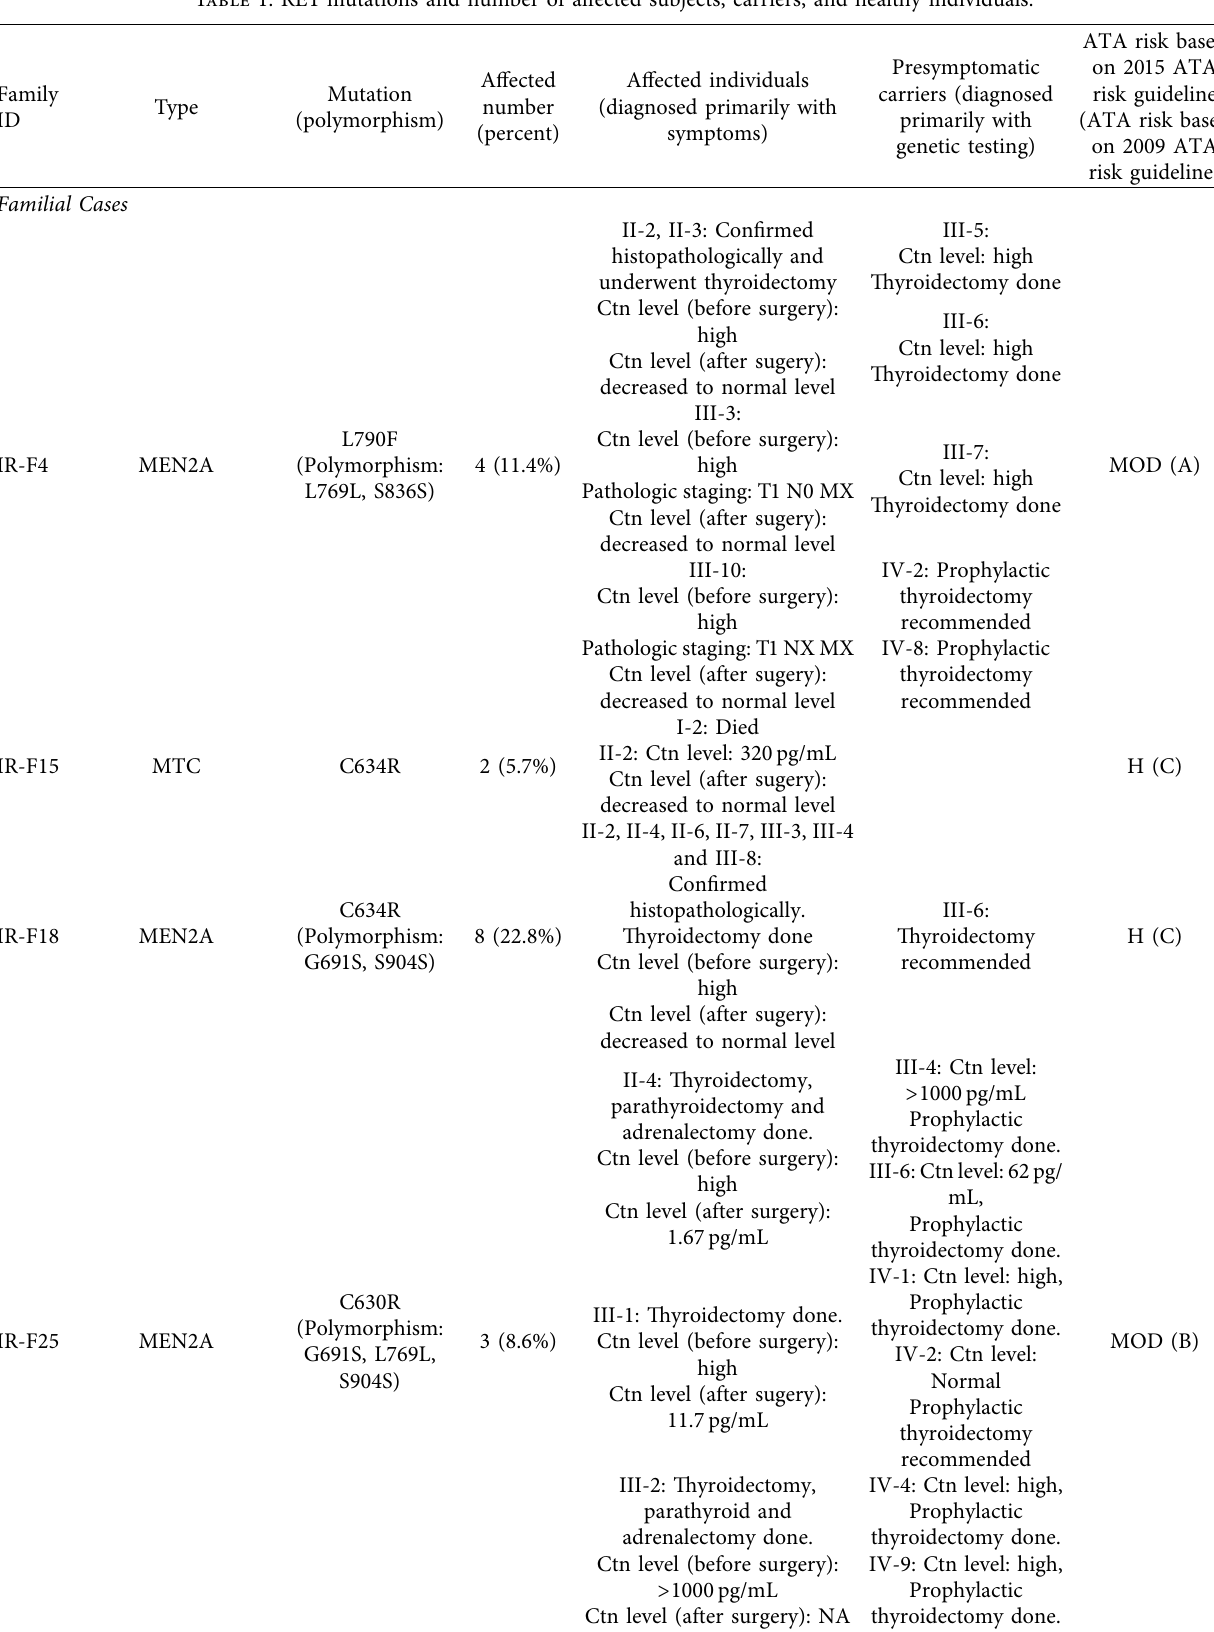
Table 1: RET mutations and number of affected subjects, carriers, and healthy